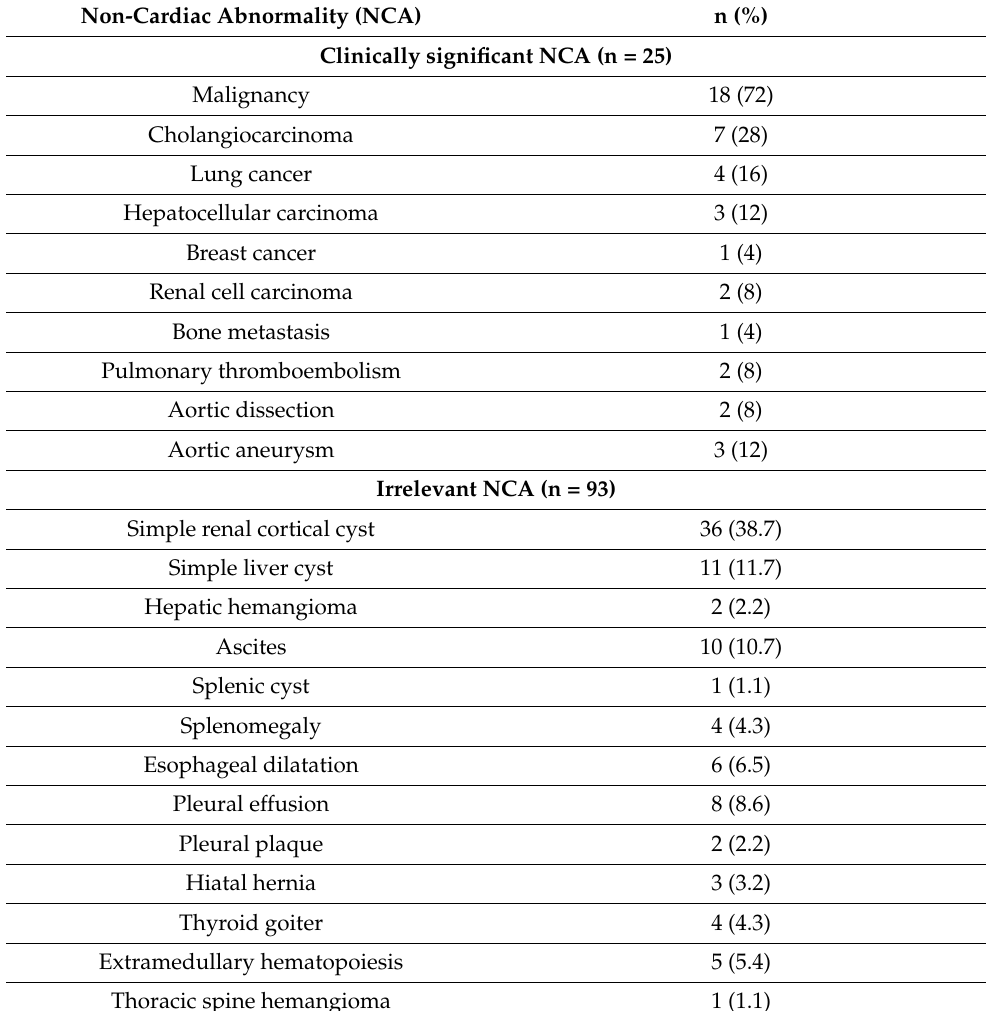
Table 2. Incidental non-cardiac abnormality (NCA) on cardiac MRI.